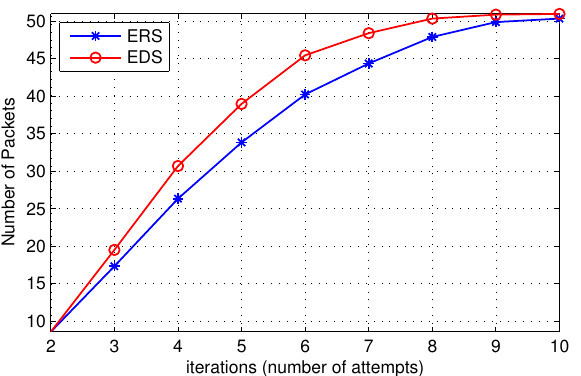
Figure 10. Cost of a single search query.